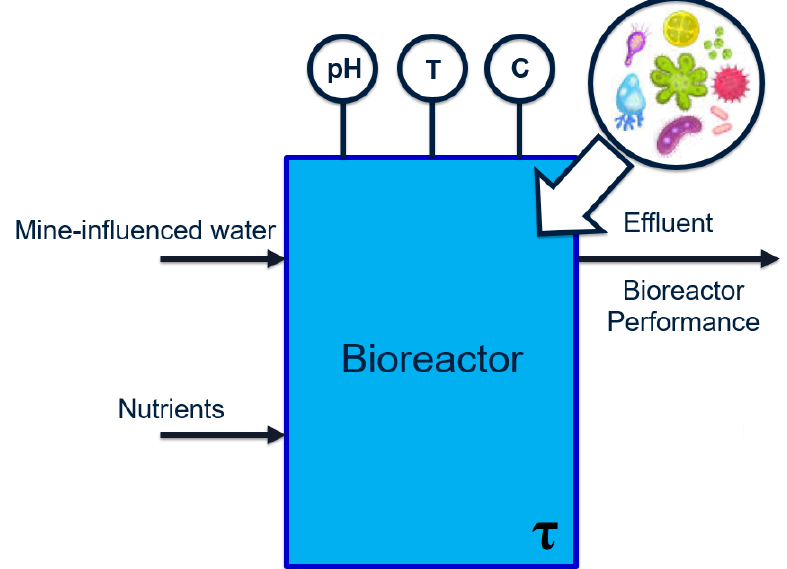
Figure 2. A simple bioreactor schematic, with wastewater and biological nutrients as inlets, and treated effluent as outlet. The system contains directly-measurable macro variables related to water chemistry (such as contact time τ ), and difficult-to-measure micro variables reflecting the metabolism of